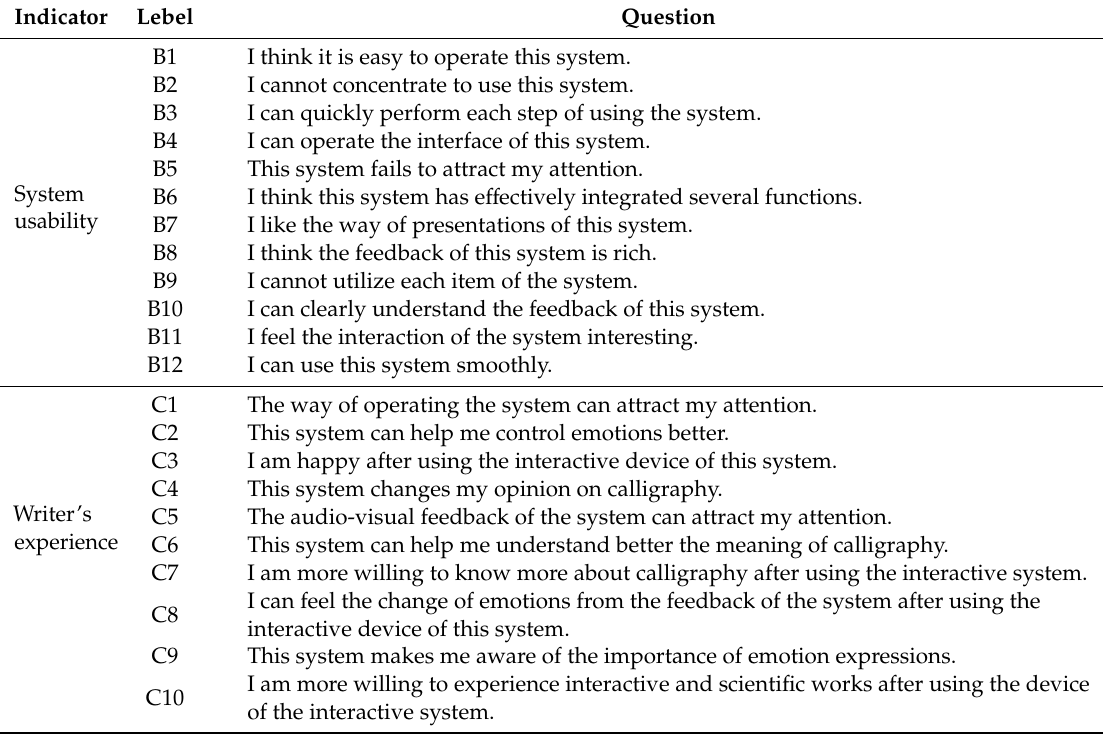
Table 6. List of questions of the questionnaire for evaluating system usability and writers’